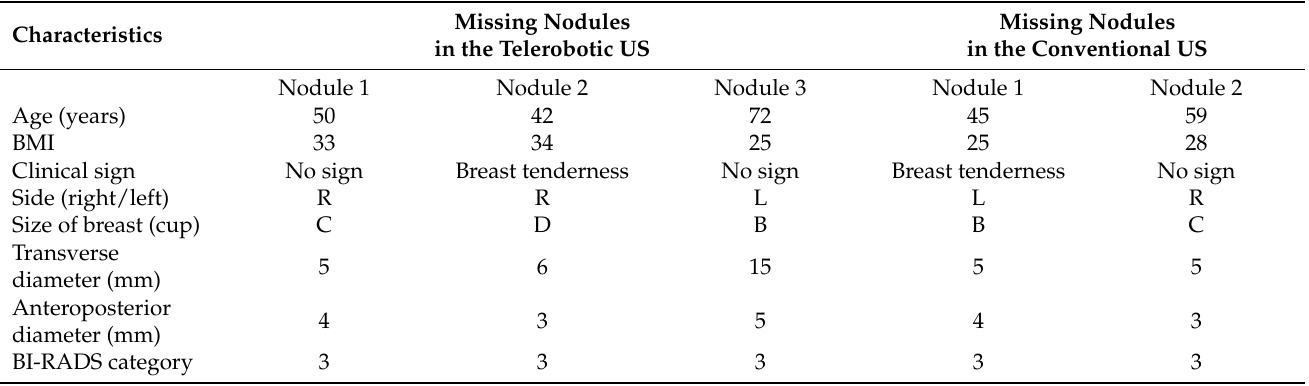
Table 2. Missing breast nodules in the 5G-based telerobotic and conventional US in Scenario A. BMI: calculated as weight (kg)/height (m) 2 . Abbreviations: US: ultrasound; BI-RADS: Breast Imaging Reporting and Data System. BMI: body mass index.